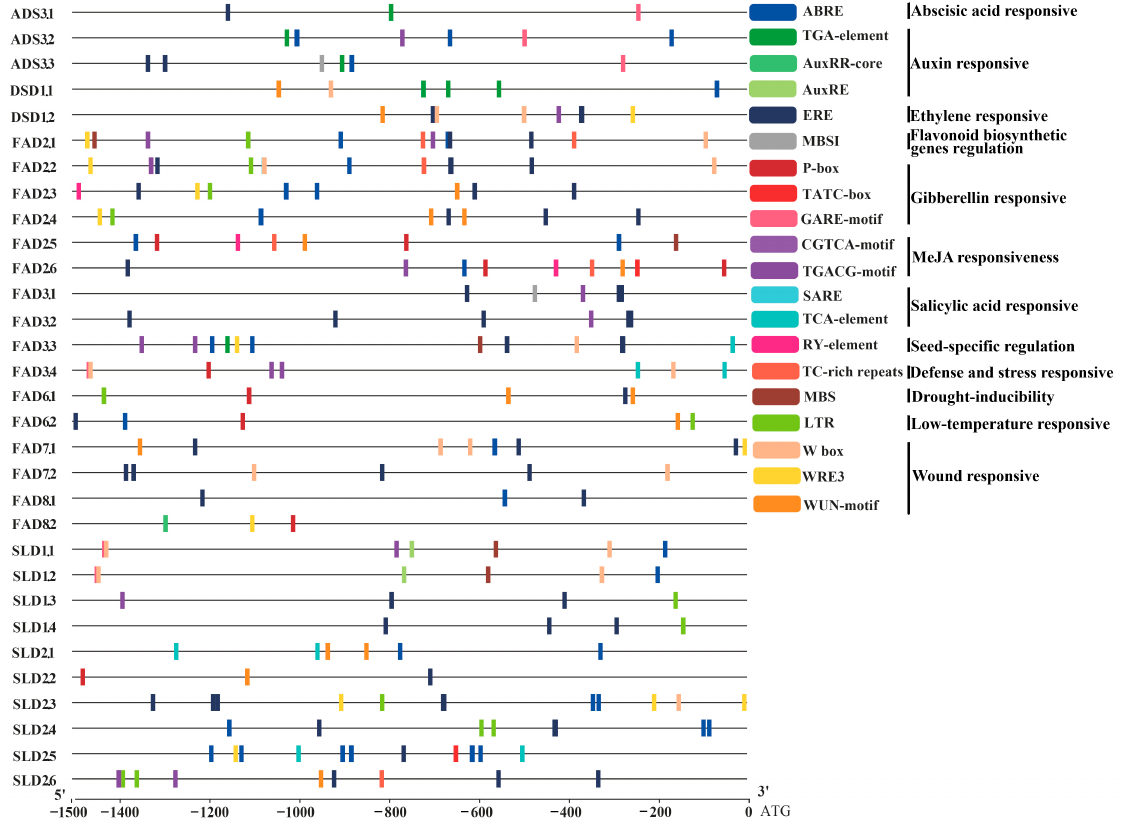
Figure 5. Predicted hormone responsiveness or stress-related cis-elements in Ah|FAD promoters (1500 bp upstream region).